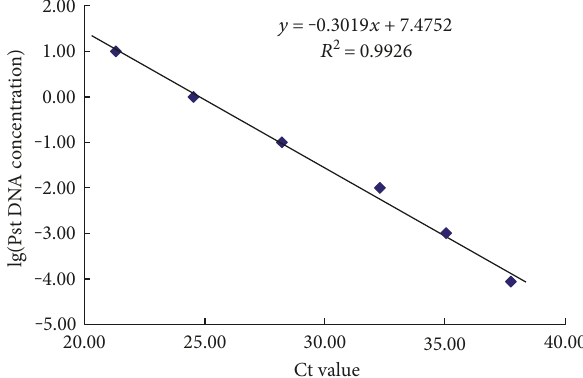
Figure 3: The standard curve of duplex TaqMan real-time PCR for quanti fi cation of Pst DNA and the corresponding linear regression equation.